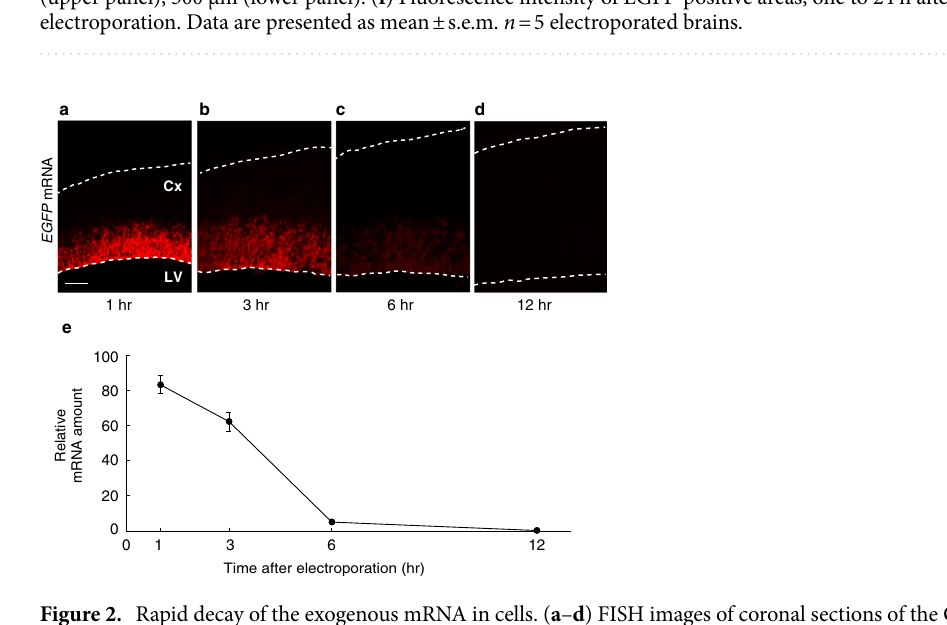
Figure 2. Rapid decay of the exogenous mRNA in cells. ( a – d ) FISH images of coronal sections of the Cx, one to 12 h after electroporation, which was performed as described in Fig. 1. The EGFP mRNA was detected in the ventricular zone. Scale bar, 50 µm. ( e ) The relative amount of the EGFP mRNA, one to 12 h after electroporation, which was measured using fluorescent signals of FISH. Data are presented as mean ± s.e.m. n = 5 electroporated